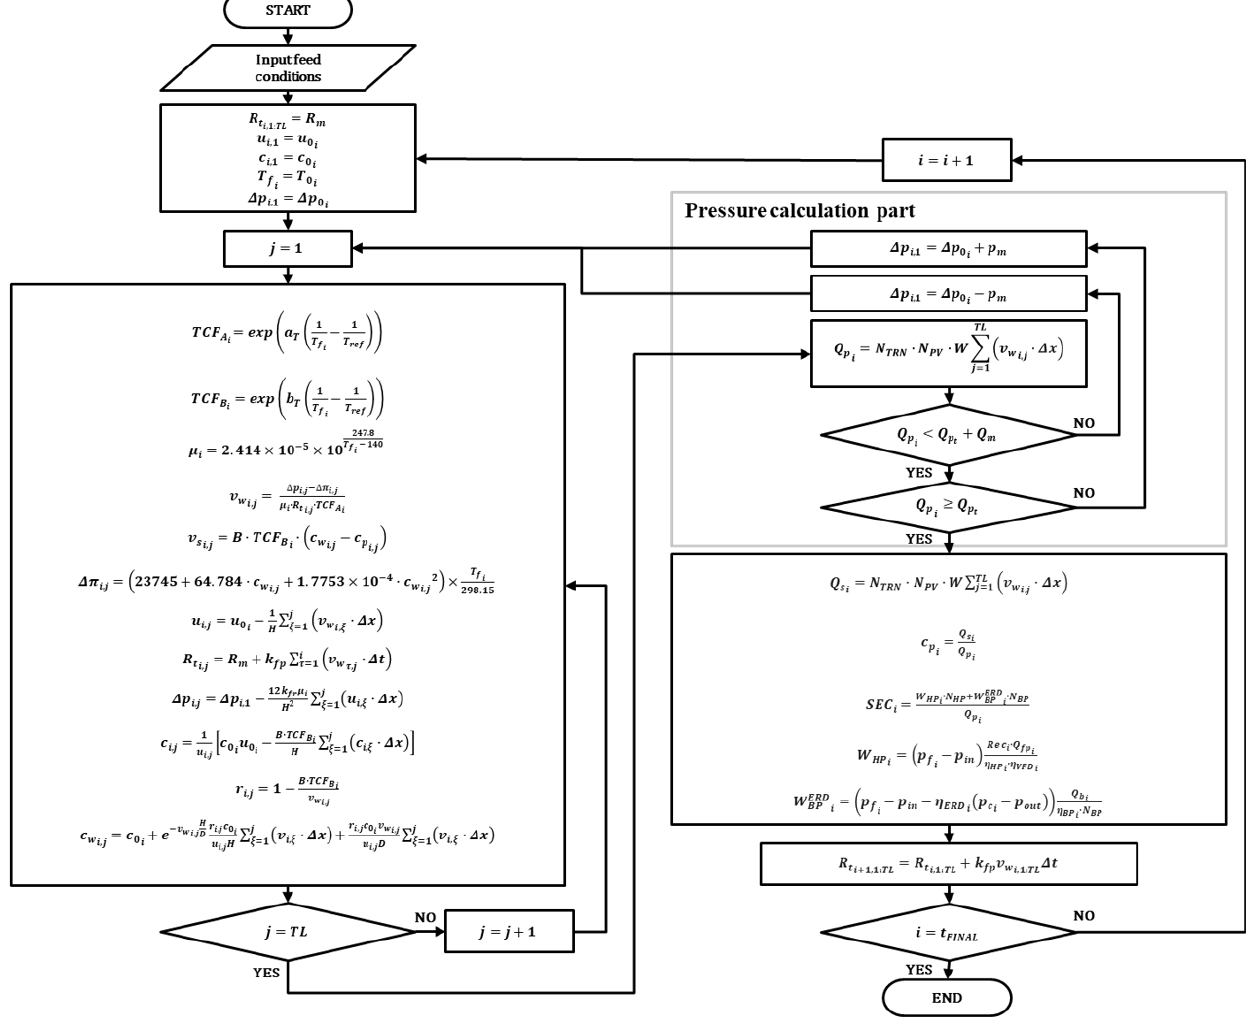
Figure 2. Flow chart for the seawater reverse osmosis process model in constant permeate mode with time-variant feed water condition input.